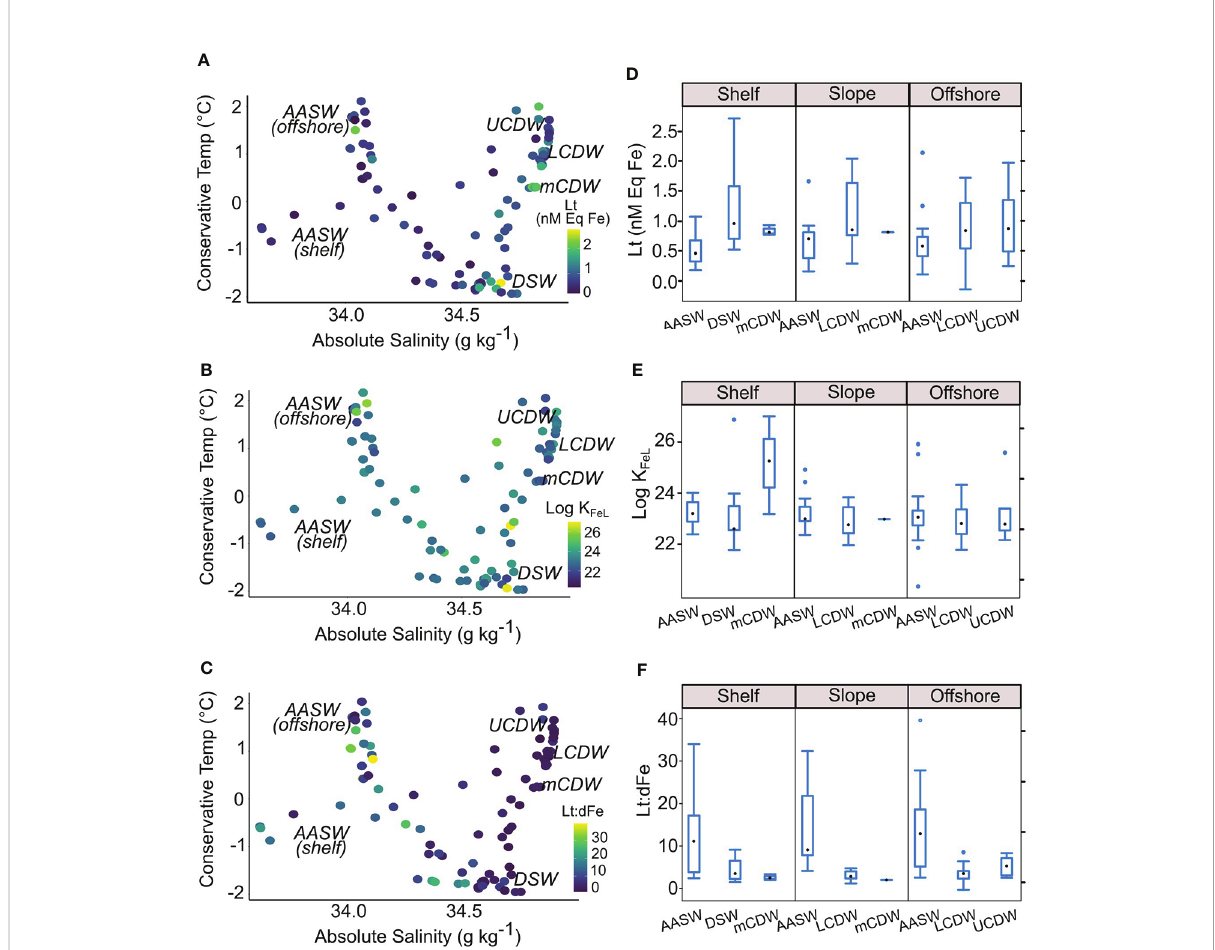
FIGURE 2 Temperature – salinity diagram representing Lt (A) , Log K FeL (B) and Lt:dFe (C) in water masses present across the region. Box-and-Whisker plot illustrating Lt (D) , Log K FeL (E) and the Lt:dFe ratios (F) across water masses and frontal regions (including shelf, slope and offshore). AASW: Antarctic Surface Water, UCDW: Upper Circumpolar Deep Water, LCDW: Lower Circumpolar Deep Water, mCDW: modi fi ed Circumpolar Deep Water, DSW: Dense Shelf